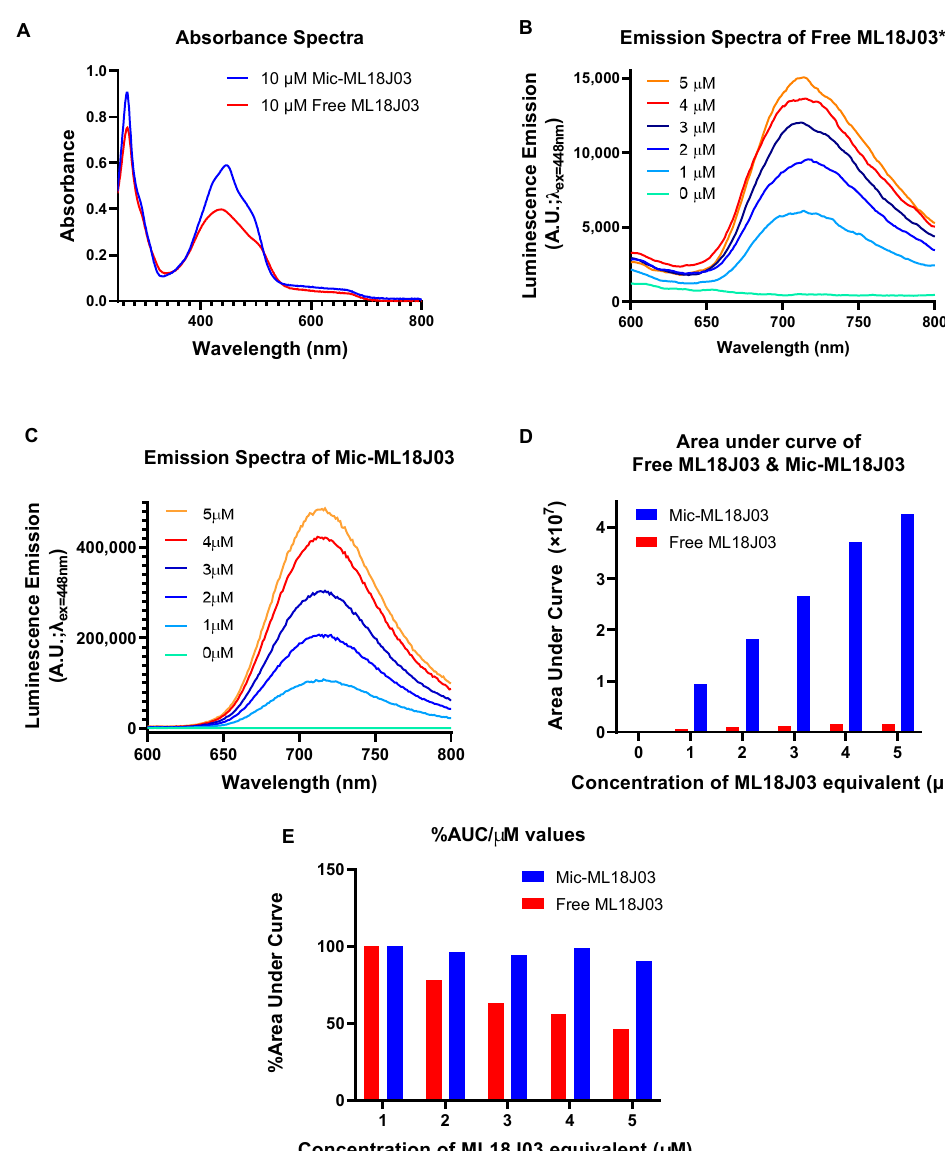
Figure 2. ( A ) Absorbance spectra of free ML18J03 (1% DMSO in PBS) and Mic-ML18J03 (in PBS) at 10 μ M PS equivalent. Raw luminescence emission spectra ( λ Exc = 448 nm, λ Emi = 600–800 nm) of 1–5 μ M of ( B ) free ML18J03 in 1% DMSO in PBS* and ( C ) Mic-ML18J03 in PBS. ( D ) Area under the curve analyses for the luminescence emission spectra of 1–5 μ M of free ML18J03 and Mic-ML18J03. ( E ) Percent-area under the curve analyses of 1–5 μ M of free ML18J03 and Mic-ML18J03 with respect to the lowest concentration of 1 μ M ML18J03 equivalent, demonstrating the concentration-dependent static quenching only observed with free ML18J03. (* Smoothing curve analysis applied with a factor of 10 for clarity in (B). Only raw spectral data were used for further analysis).